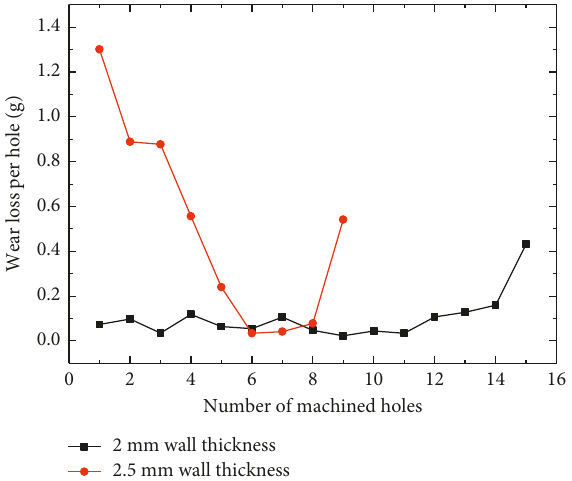
Figure 8: Wear rates of the bit under different bit loads. Figure 7: Wear rates of the bit under different wall